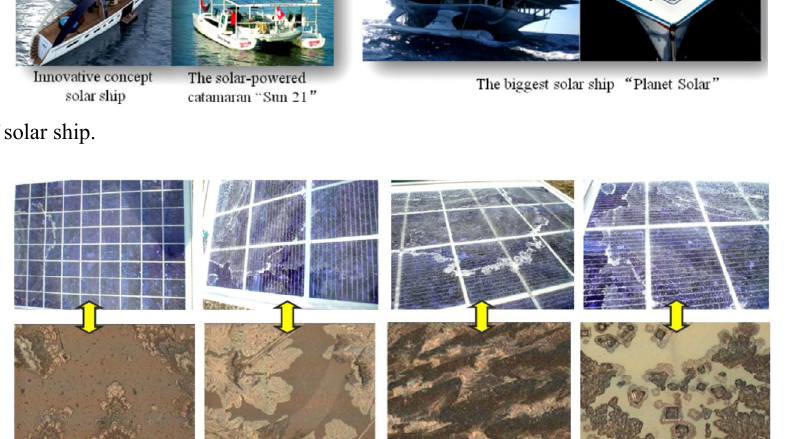
Fig. 9 Salt-water experiment of cell glass cover conducted under simulated marine